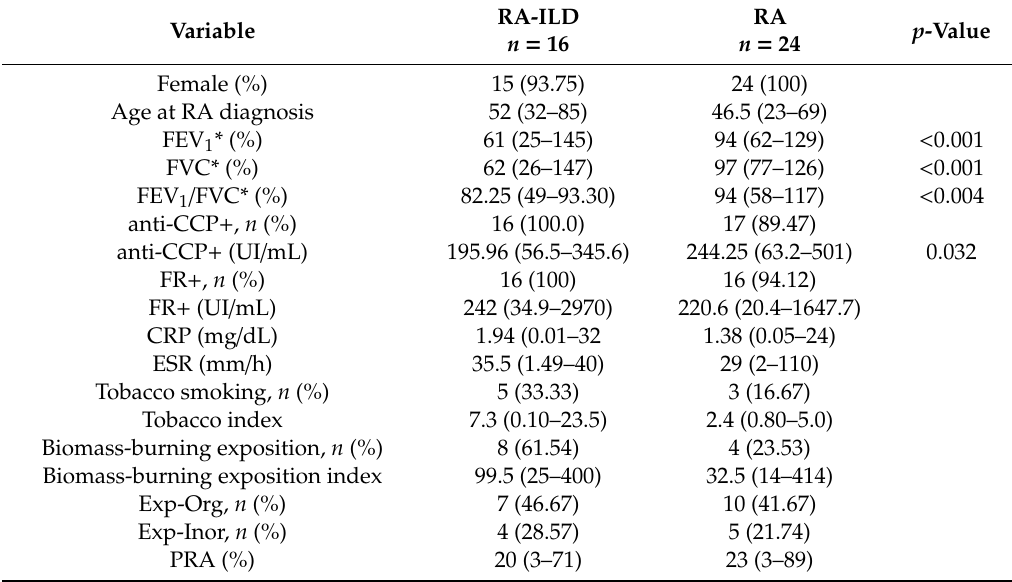
Table 2. Demographic and clinical characteristics of PRA positive